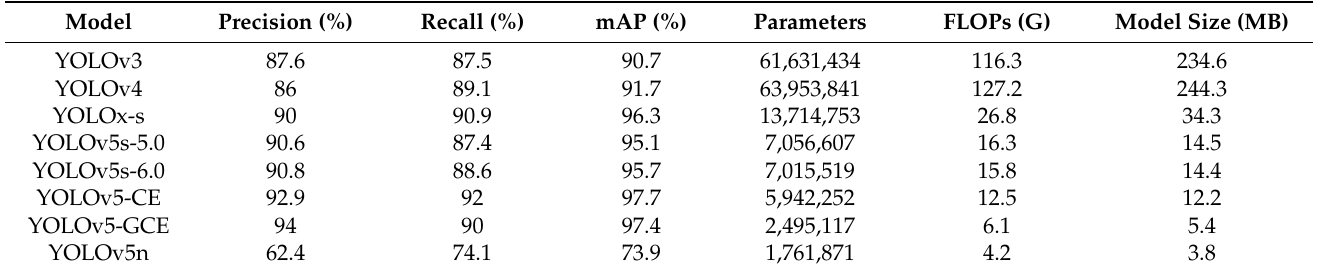
Table 9. Comparison results of the mainstream YOLO target detection algorithms and improved algorithms.